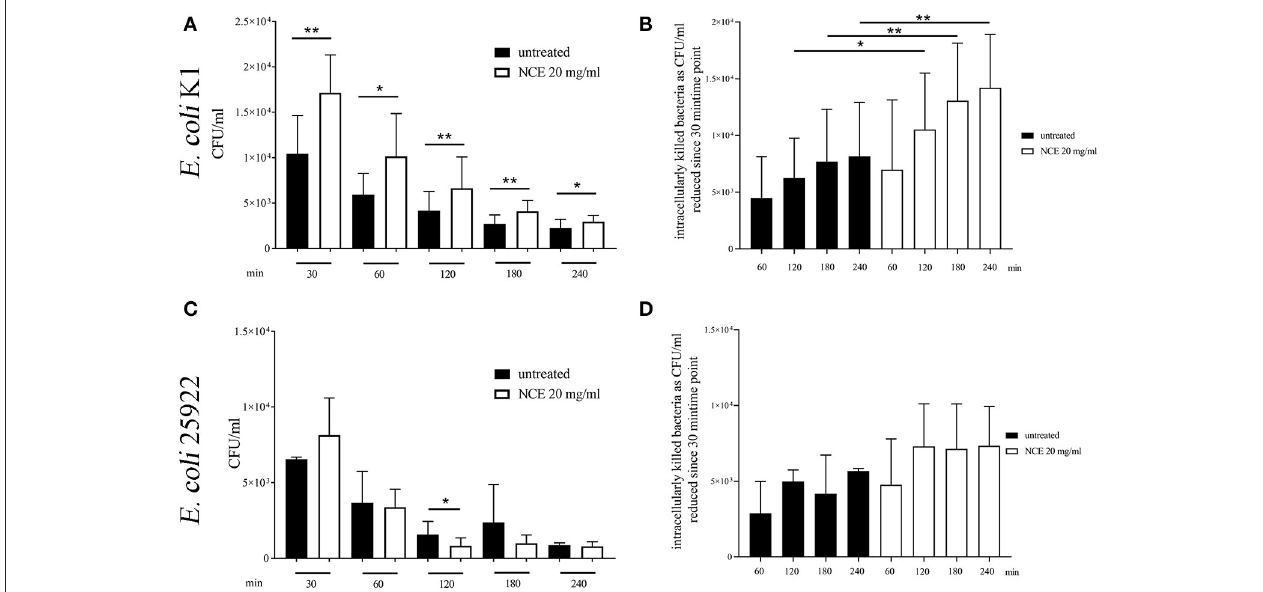
FIGURE 7 | Phagocytosis of E. coli strains after pre-simulation of bovine and human whole blood with 20mg/ml natural crude extract (NCE). Human and bovine whole blood were pre-stimulated for 2h with 20mg/ml NCE. Afterwards, human blood was co-incubated with E. coli K1 (A,B) and bovine blood with E. coli 25922 (C,D) for 30min. Extracellular bacteria were killed with gentamicin. Untreated blood was used as a control. Phagocytosed E. coli K1 were recovered by lysing the eukaryotic cells and plating the samples on blood agar. Cells of NCE-stimulated human blood phagocytosed significantly more E. coli K1 after 30min of co-incubation compared to the control (A) , and intracellular killing of E. coli K1 was higher in the NCE-treated group compared to the control (B) . Cells of NCE stimulated bovine blood had a tendency to phagocytose more E. coli 25922 after 30min (C) . The number of intracellular killed E. coli 25922 was slightly increased in NCE-treated cells (D) compared to untreated cells. The assay was performed with blood from healthy donors (human n = 5, bovine n = 3) as independent experiments. All data are shown as means ± SD. Statistical analysis was done by one-tailed, paired Student’s t -test. * P < 0.05 and ** P < 0.01 were considered significant.